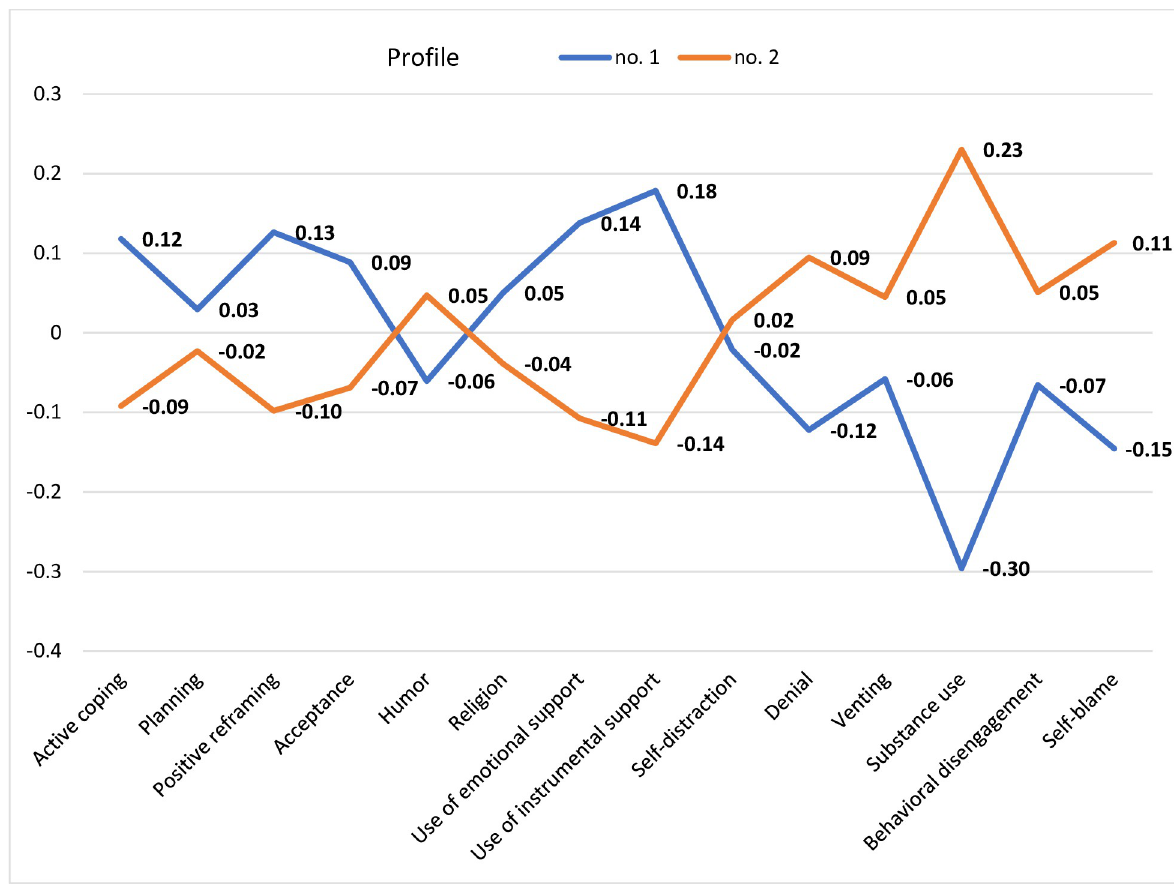
Fig 2. Profiles of coping extracted in the studied samples.